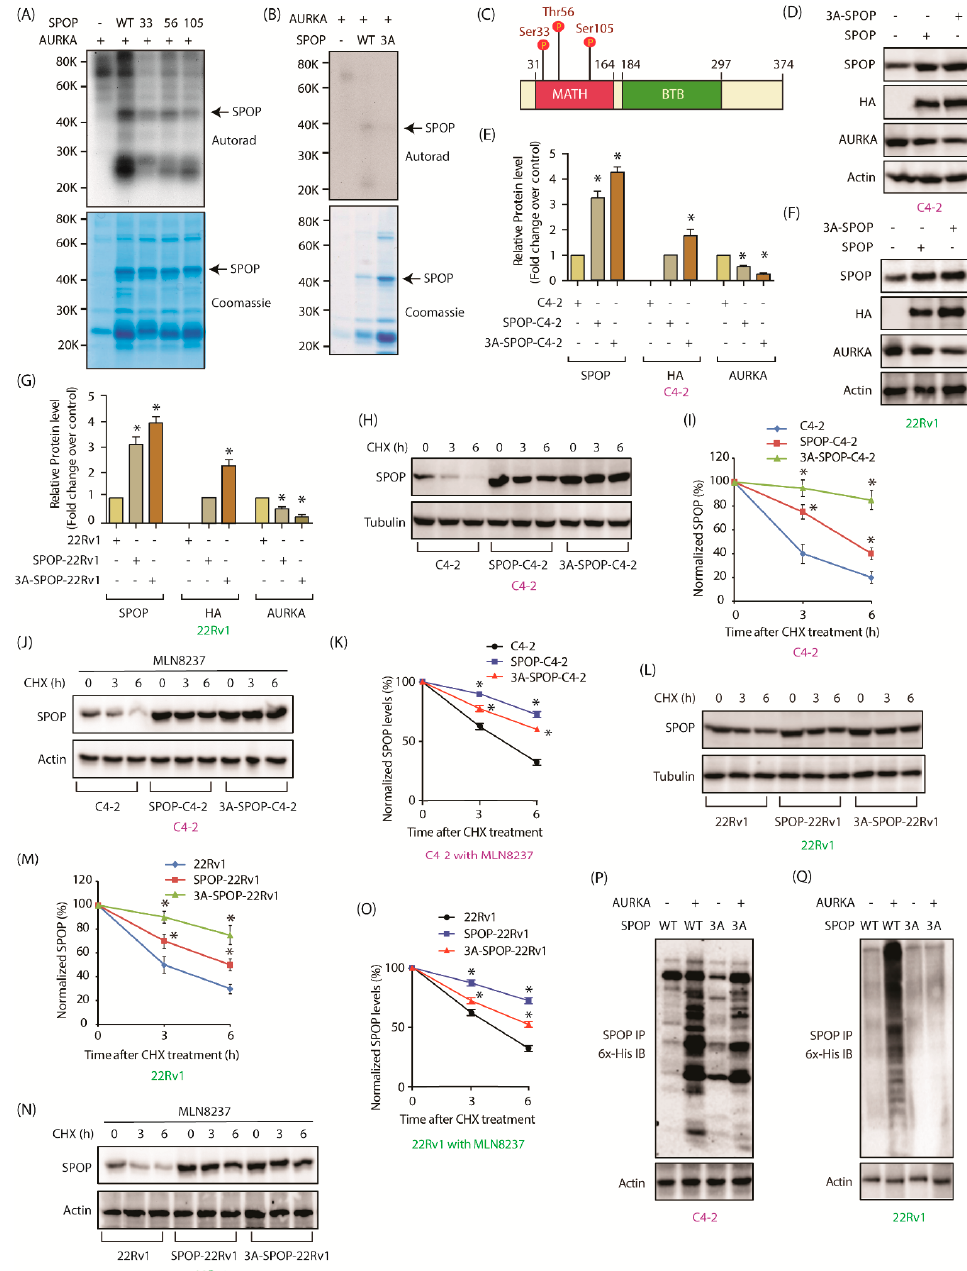
Figure 4. AURKA degrades SPOP by phosphorylation. ( A ) AURKA phosphorylates SPOP at S33, T56, and S105 positions. All three SPOP mutants were 6x-His-tagged. Kinase assay was conducted for 30 min. The top panel shows autoradiography and the bottom panel shows Coomassie staining. ( B ) AURKA phosphorylates SPOP only at S33, T56, and S105, as the corresponding 3A-phospho-resistant mutant did not show any phosphorylation. ( C ) S33, T56 and S105 are within the MATH domain of SPOP. ( D ) Phospho-resistant SPOP is expressed at relatively higher level compared to wild-type SPOP. C4-2 cells were infected with HA-tagged wild-type SPOP or 3A-SPOP retrovirus for 36 h followed by immunoblot analysis. ( E ) Quantification of wild type and mutant SPOP obtained from three independent experiments. The data are presented as mean ± SEM obtained from three independent experiments. * p < 0.05 vs. C4-2 control cells. ( F ) SPOP protein levels in 22Rv1 cells infected with HA-tagged wild-type SPOP or 3A-SPOP. ( G ) Quantification of SPOP obtained from three independent experiments in 22Rv1 cells. ( H ) Phospho-resistant SPOP has increased stability compared to wild type SPOP. SPOP levels were analyzed in C4-2, SPOP-C4-2 and 3A-SPOP-C4-2 cells treated with cycloheximide (10 µ M) for 3 and 6 h. ( I ) Graphical representation of SPOP degradation profile in